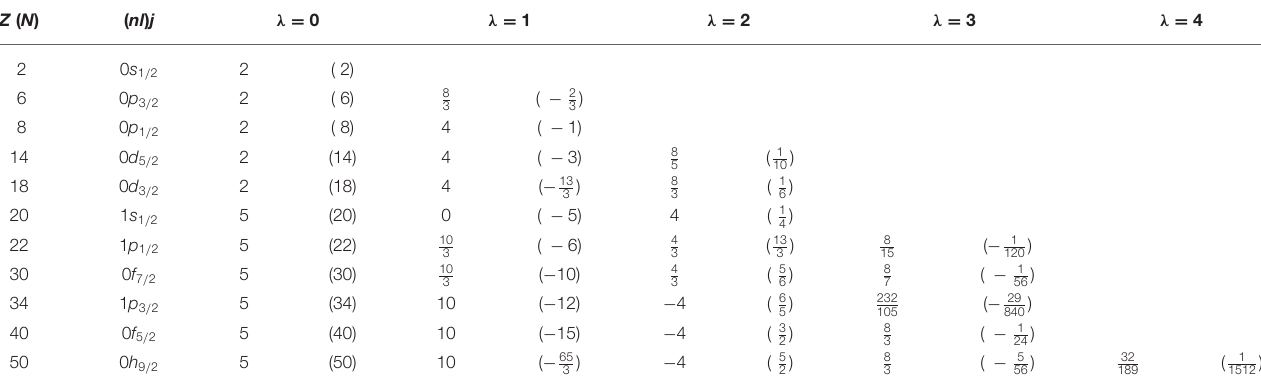
Table adapted from Papoulias and Kosmas [61] under the terms of the Creative Commons Attribution 4.0 International license.